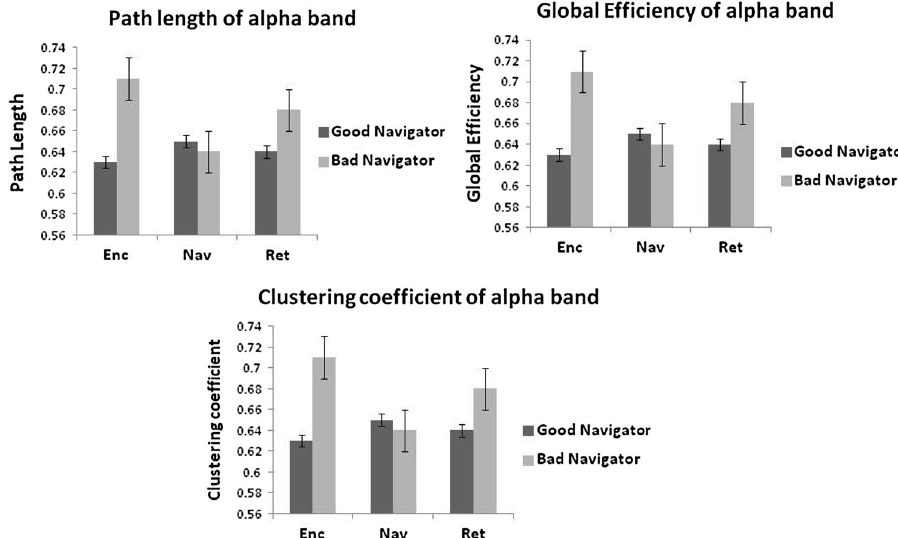
Fig. 3 Graph parameters for Alpha (8–13 Hz) wave synchronisation during encoding (Enc) phase, navigation (Nav) phase and retrieval (Ret) phase of the task. Only clustering coefficient (CC) was found to be significant in Ret phase, p =